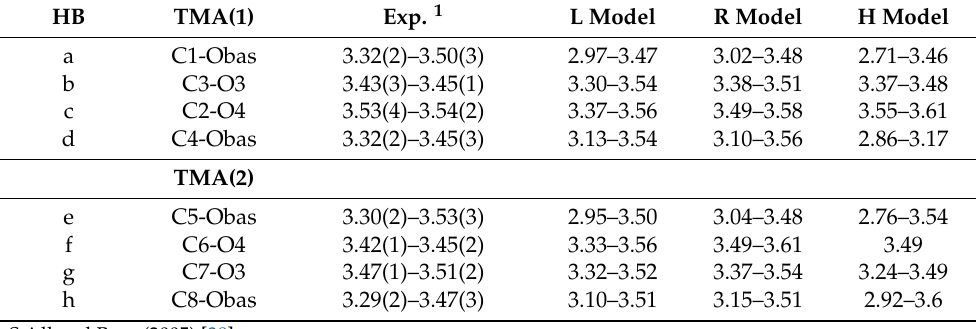
Table 5. Hydrogen bonds (HB): D ··· A distances in TMA-H models, [Å].